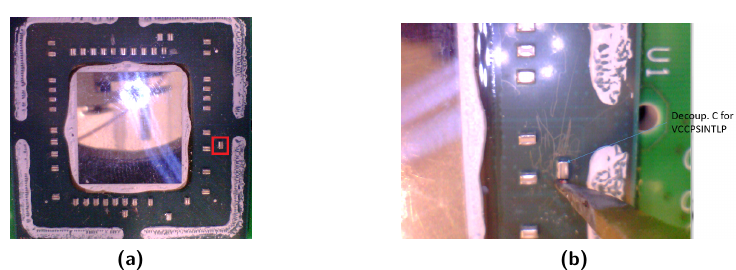
Figure 2: Decapsulated chip of the Xilinx ZU+ (a) and placement of the probe next to the decoupling capacitor